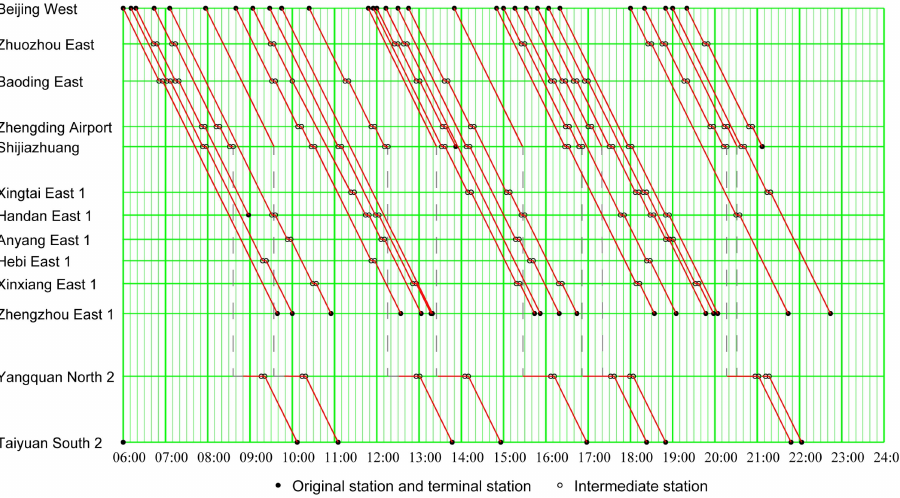
Figure 12. Train diagram. Table 6. Distribution of average load factor for all operated